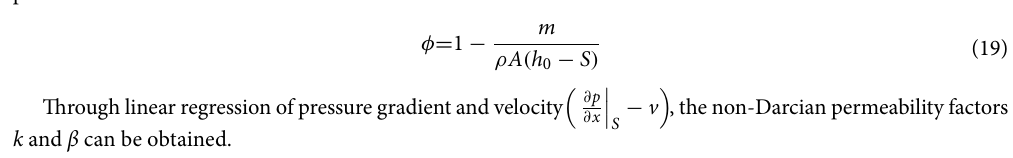
the coordinate axis, the horizontal axis represents the penetration velocity, and the vertical axis represents the pressure gradient. The figure shows that when the flow rate is relatively low, the pressure gradient and the flow rate have a good linear relationship; as the seepage velocity increases, the curve shows a slope that deviates from the linear rule, gradually approaching the pressure gradient axis, showing a significant non-linear Darcy phenom- enon. If we follow the Darcy’s equation, we get k D = 5.09 μm 2 . According to Forchheimer’s non-Darcian seepage equation, through factor fitting, the deviation factor β is 1.96 × 10 10 /m, and k is 4.91 μm 2 , its fitted correlation